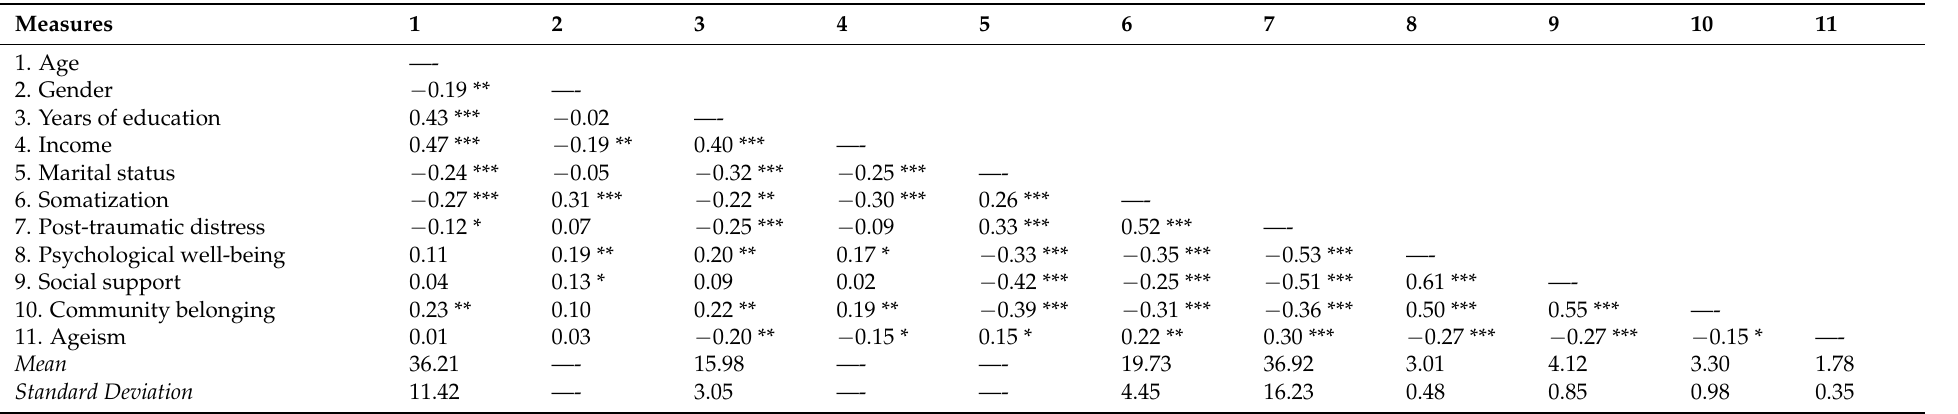
Table 1. Intercorrelations among the study